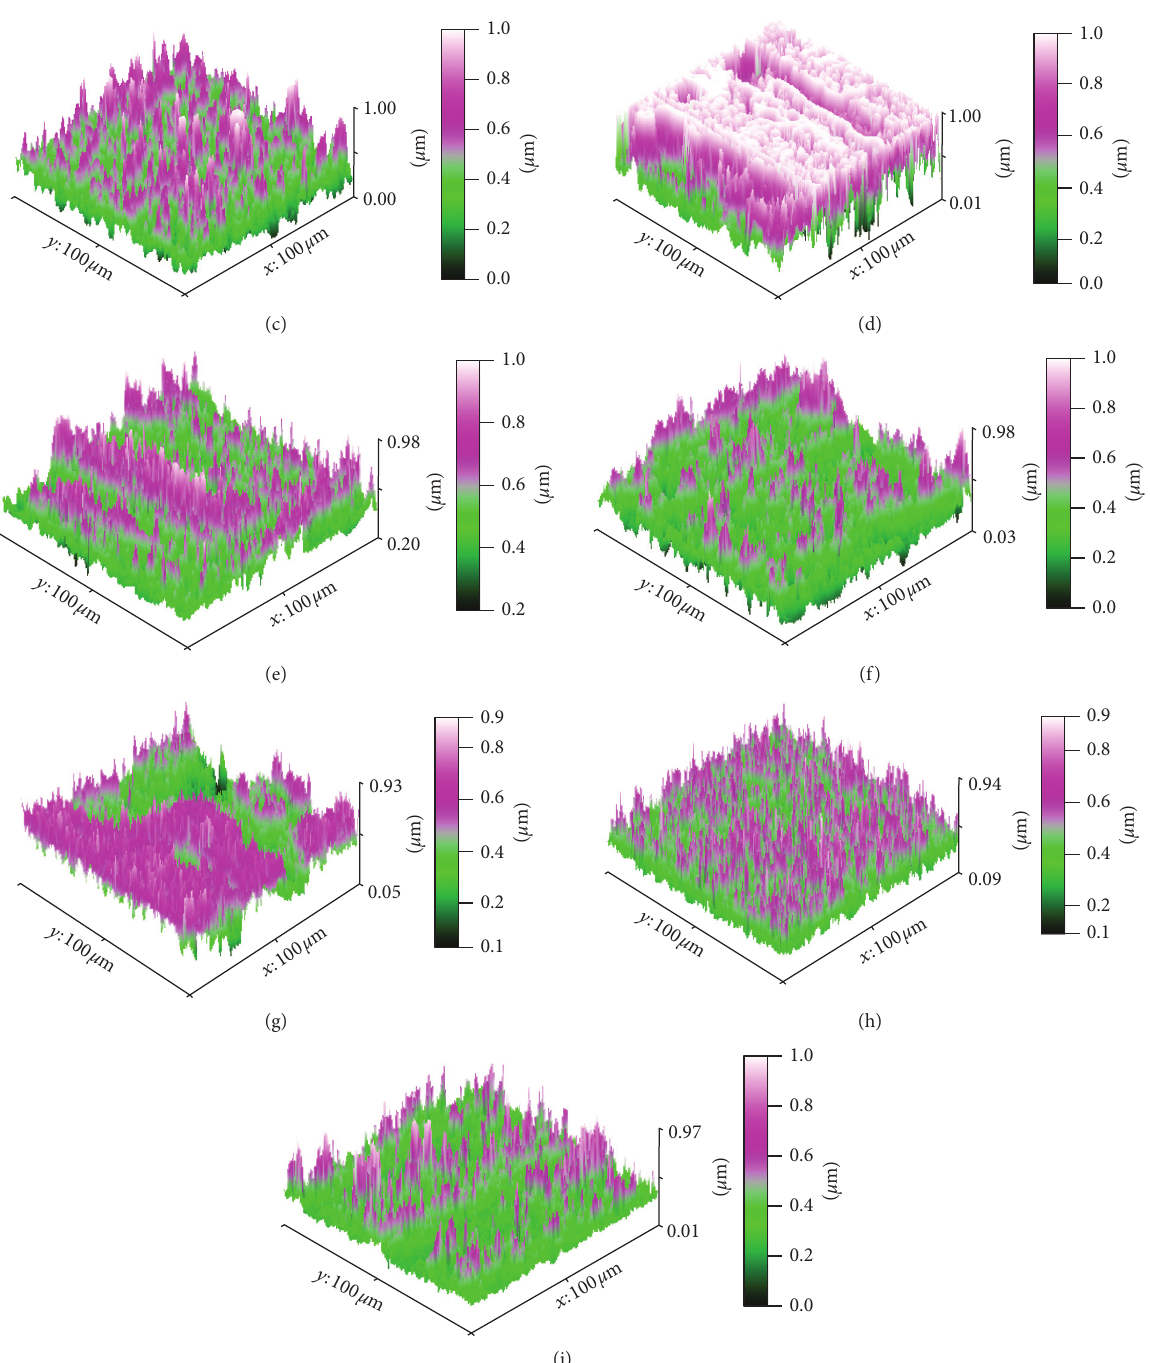
Figure 17: 3D profilometric images of the tensile test specimen as per experiment